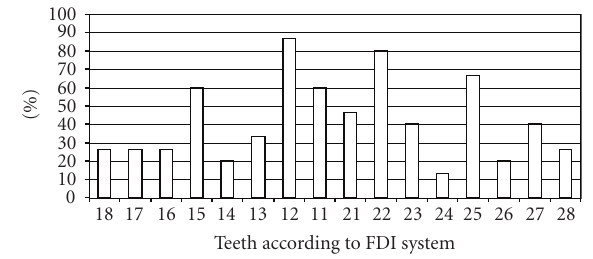
Figure 9: Frequency of agenesis of permanent upper teeth in 15 patients with ARS and hypodontia.